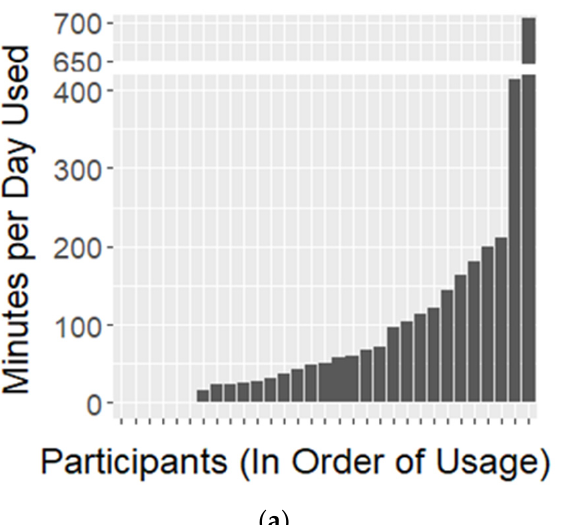
Figure 1. Participant Usage Patterns. ( a ) Minutes per day used by each participant. Participants are ordered by usage (n = 31). ( b ) Days per week for each participant. Participants are ordered by usage (n = 31).